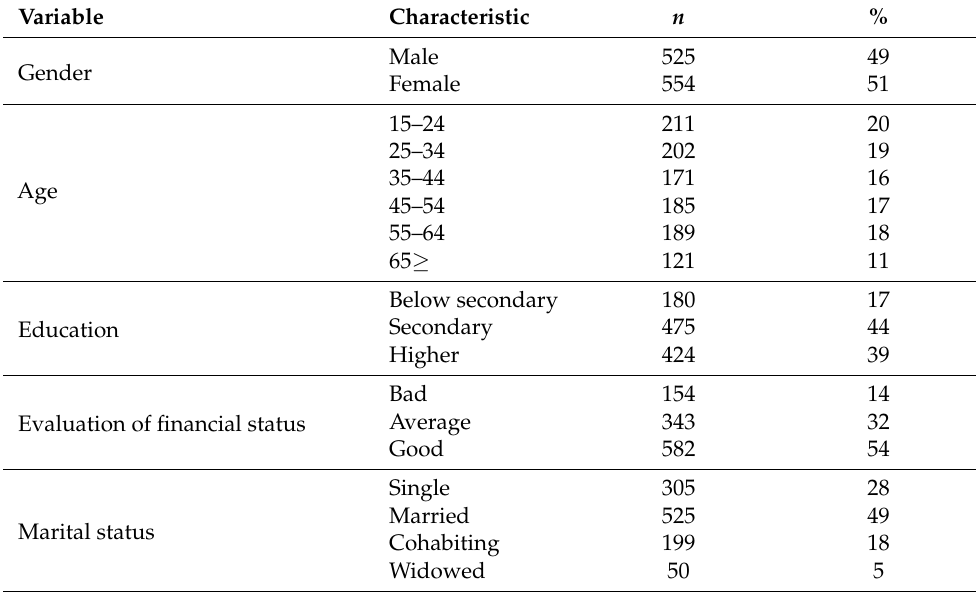
Table 1. Characteristics of the research